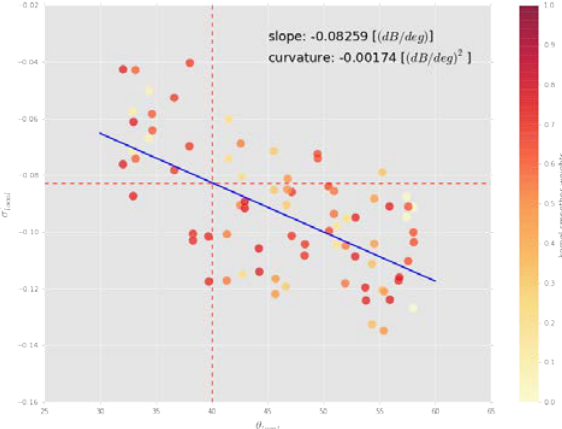
Figure 6: Slope and Curvature estimation using LLR with an Epanechnikov kernel smoother for a single evaluation day and a time window half-length of 21 days.